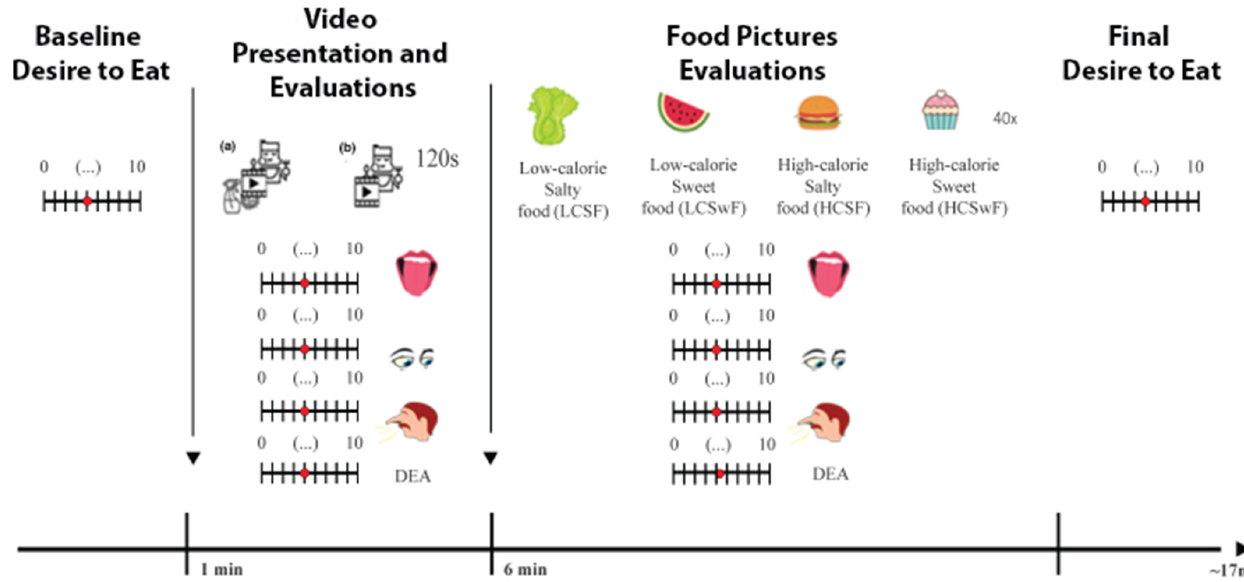
Figure 1. Task design. In the first minute of the task, participants were asked about their desire to eat at that moment. Following the presentation of the video, ( a ) Pandemic and ( b ) Non-Pandemic, participants were asked again to rate their desire to eat, as well as evaluate the visual aspect and expected flavor and smell of the foods presented in the video. Then, participants were presented with several food pictures and were instructed to evaluate them based on visual aspect, expected flavor and smell and their desire to eat each food. After completing the experiment, participants’ desire to eat was